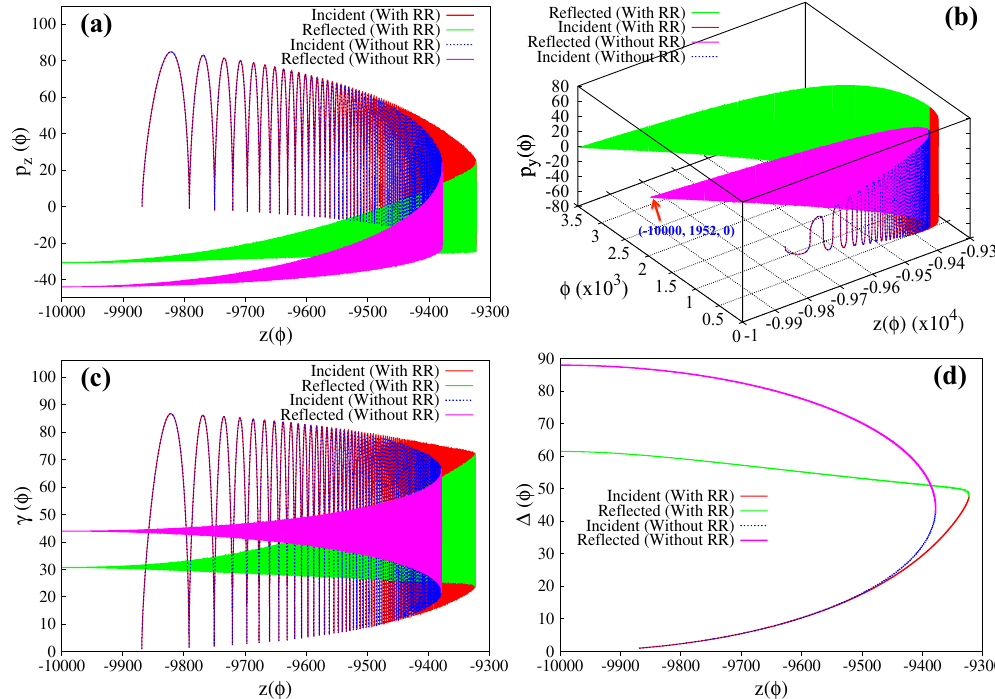
Figure 5. ( a )–( d ) Respectively represent the evolution of longitudinal and transverse momentum, the energy 0 ), intense, focused and the parameter (cid:31) , for a charged particle interacting with a linearly polarized ( δ = electromagnetic wave, in the absence/presence of radiation reaction effects. The intensity at the focal point is 8 . The initial conditions are z 0 9869 , 0 , 1000 ( 1.8 10 10 24 W / cm 2 ) and τ 0 p chosen as a 0 − � = ≈ × = − = ∼ 0 and a ( z 0 ) 62.7 < a 0 ; see text). The blue 13.1 , which satisfy the inequality given by Eq. (16) ( a P 0 z ref = = = ⊥ and magenta curves in ( a )–( d ) respectively represent the forward and reflected motion of the particle in the absence of radiation reaction effects, whereas red and green curves in the ( a )–( d ) respectively represent the forward and reflected motion of the charged particle in the presence of radiation reaction effects.